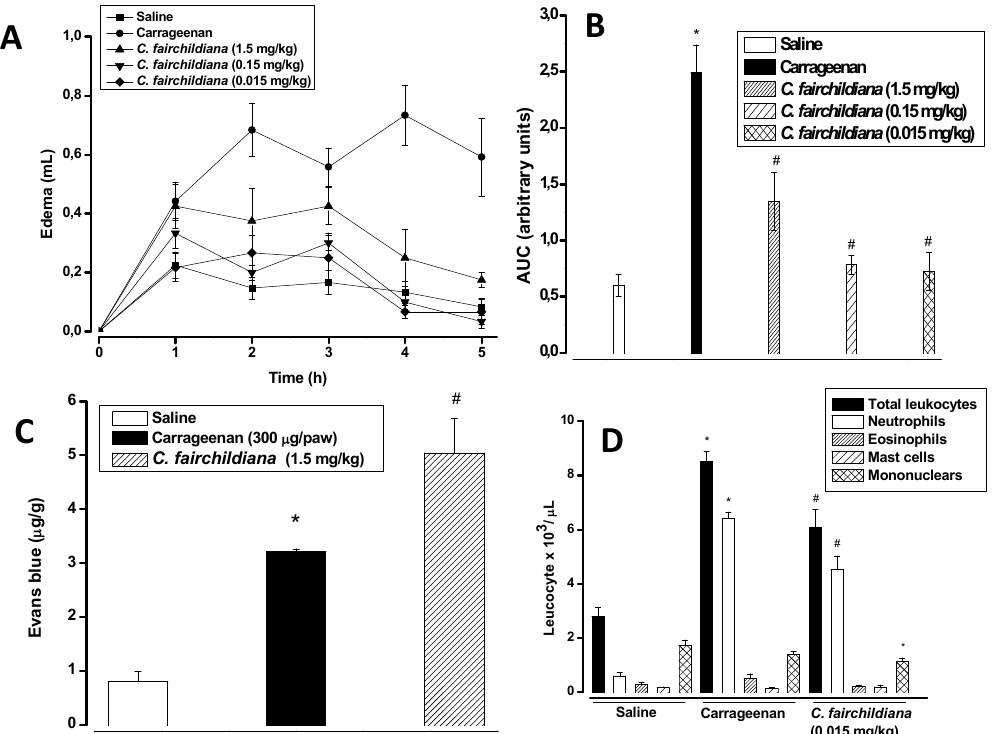
Figure 3. Anti-inflamatory effect of C. fairchildiana lectin. C. fairchildiana lectin (0.015, 0.15 or 1.5 mg/kg) was injected in rats 30 min before carrageenan at 300 μ g/paw or cavity. ( A ) Edema time-course (mL); ( B ) Area under the time-course curve-AUC (arbitrary units); ( C ) Vascular permeability (  g/g Evans blue); ( D ) Leuckocyte migration (×10 3 /  L). Mean ± S.E.M. (n = 6). * p < 0.05 compared to saline; # p < 0.05 compared to carrageenan. ANOVA and Bonferroni